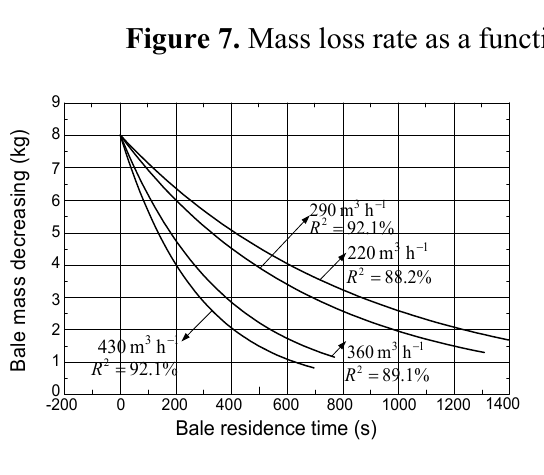
Figure 8. Mass loss rate as a function of time, recirculation